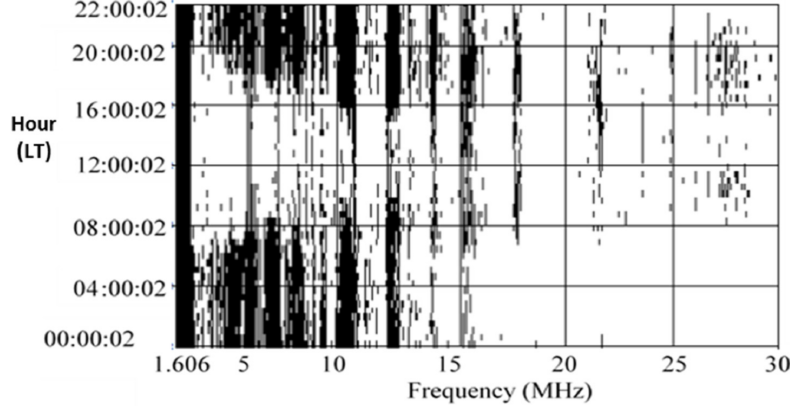
Figure 5. A diurnal plot of HF spectral occupancy at a threshold of 20 µ V/m. The 24 h variation profile for allocations in the upper HF spectrum is the inverse of that of allocations in the lower portion of the band, as it is also characterized by significant diurnal variation, albeit with interference levels that peak during the daytime hours. Typical diurnal variation profiles for allocations in the lower and upper HF bands are shown in Figure 6a,b, respectively.